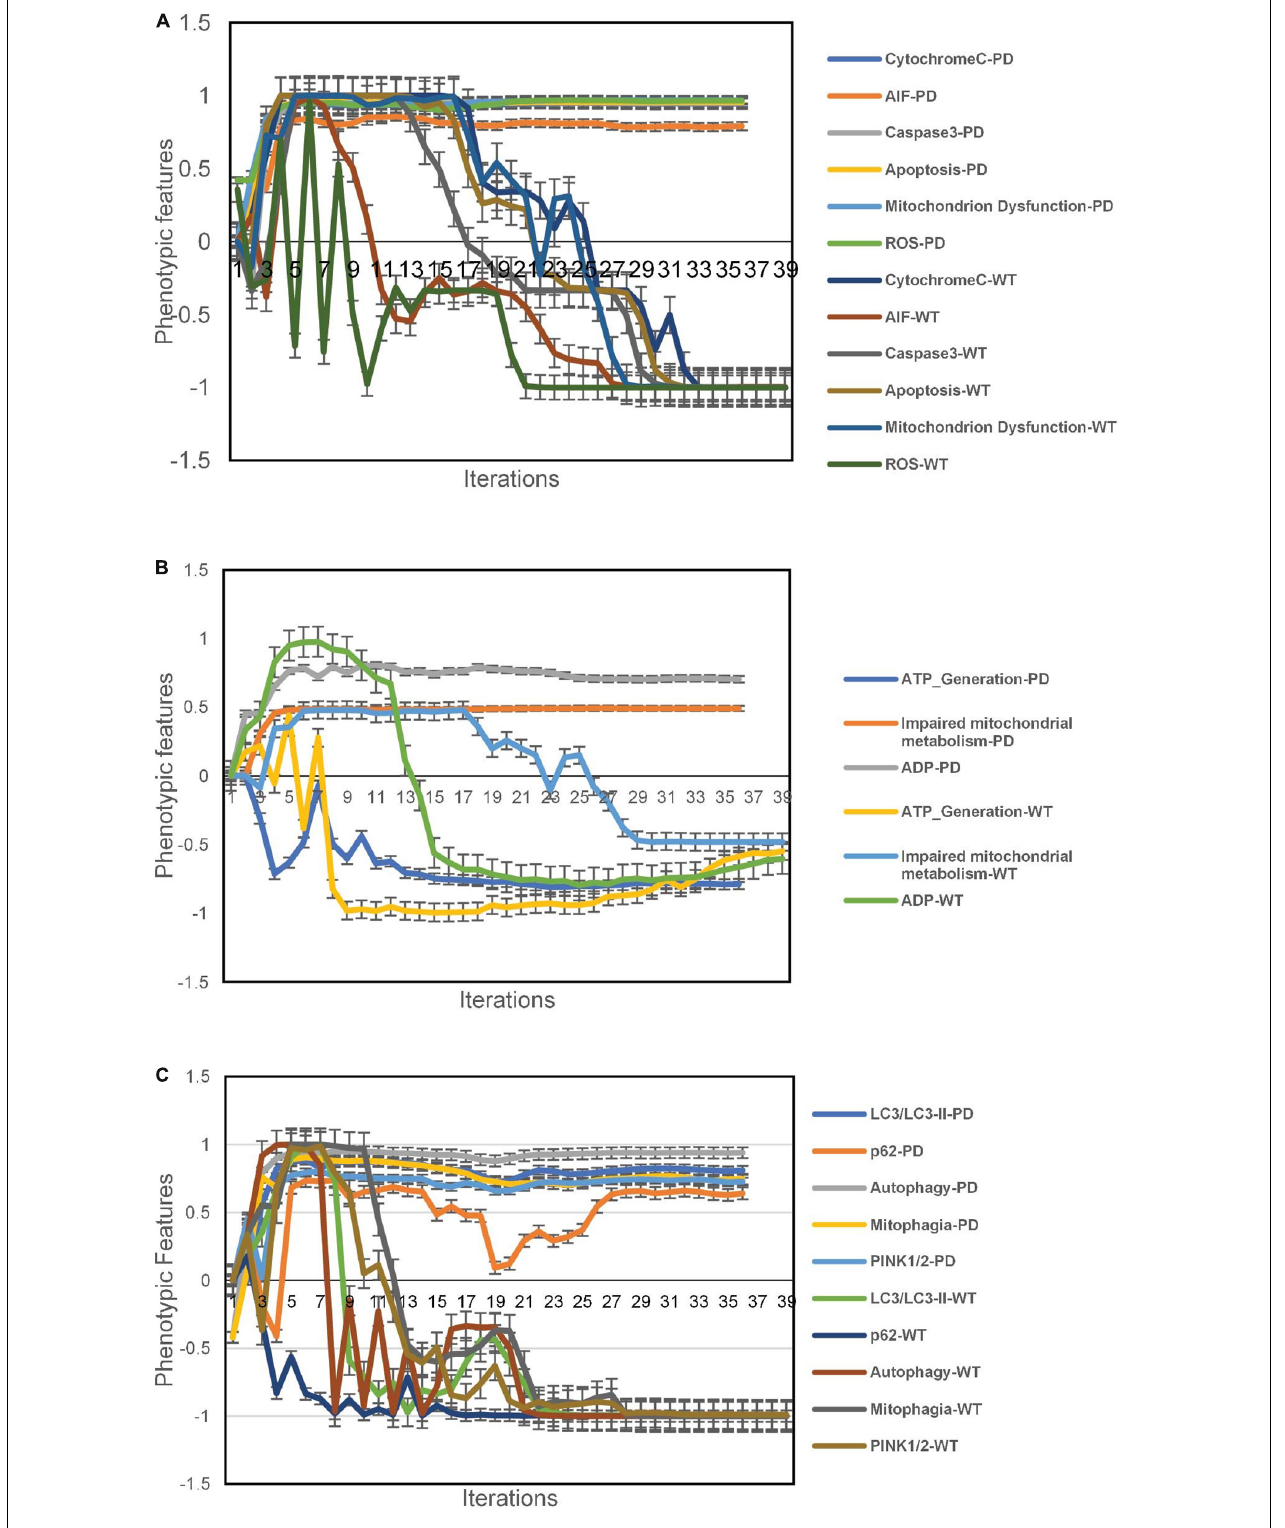
FIGURE 3 | Phenotypic feature predictions for IOPD vs. WT aiSkMC simulations. (A) altered mitochondrial physiology and function in aiSkMC simulations. (B) Defective mitochondrial bioenergetics in IOPD SkMC simulations. (C) Defective autophagy and mitophagy in IOPD aiSkMC simulations. Data are representative of three independent simulation experiments; e rror bars indicate ± SEM.